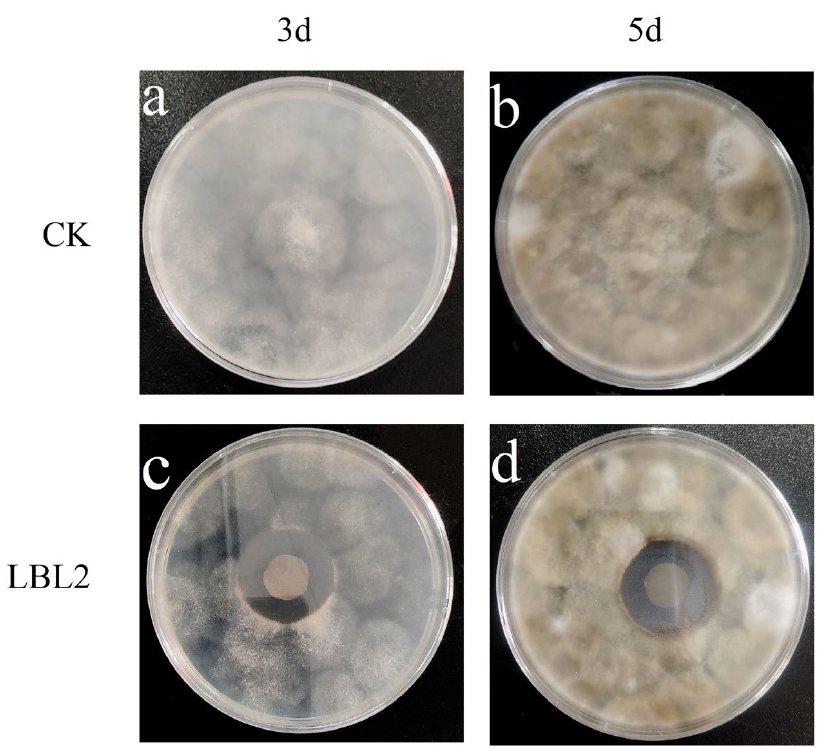
Figure 12. Inhibitory zones of CK and LBL2 films with different days against Alternaria. ( a ) Day 3 inoculation in CK group, ( b ) Day 5 inoculation in CK group, ( c ) Day 3 inoculation in LBL2 group, ( d ) Day 5 inoculation in LBL2 group. 3.10. Effects of Different Treatments on Decay Rate, Firmness, Total Mold Number and Appearance of